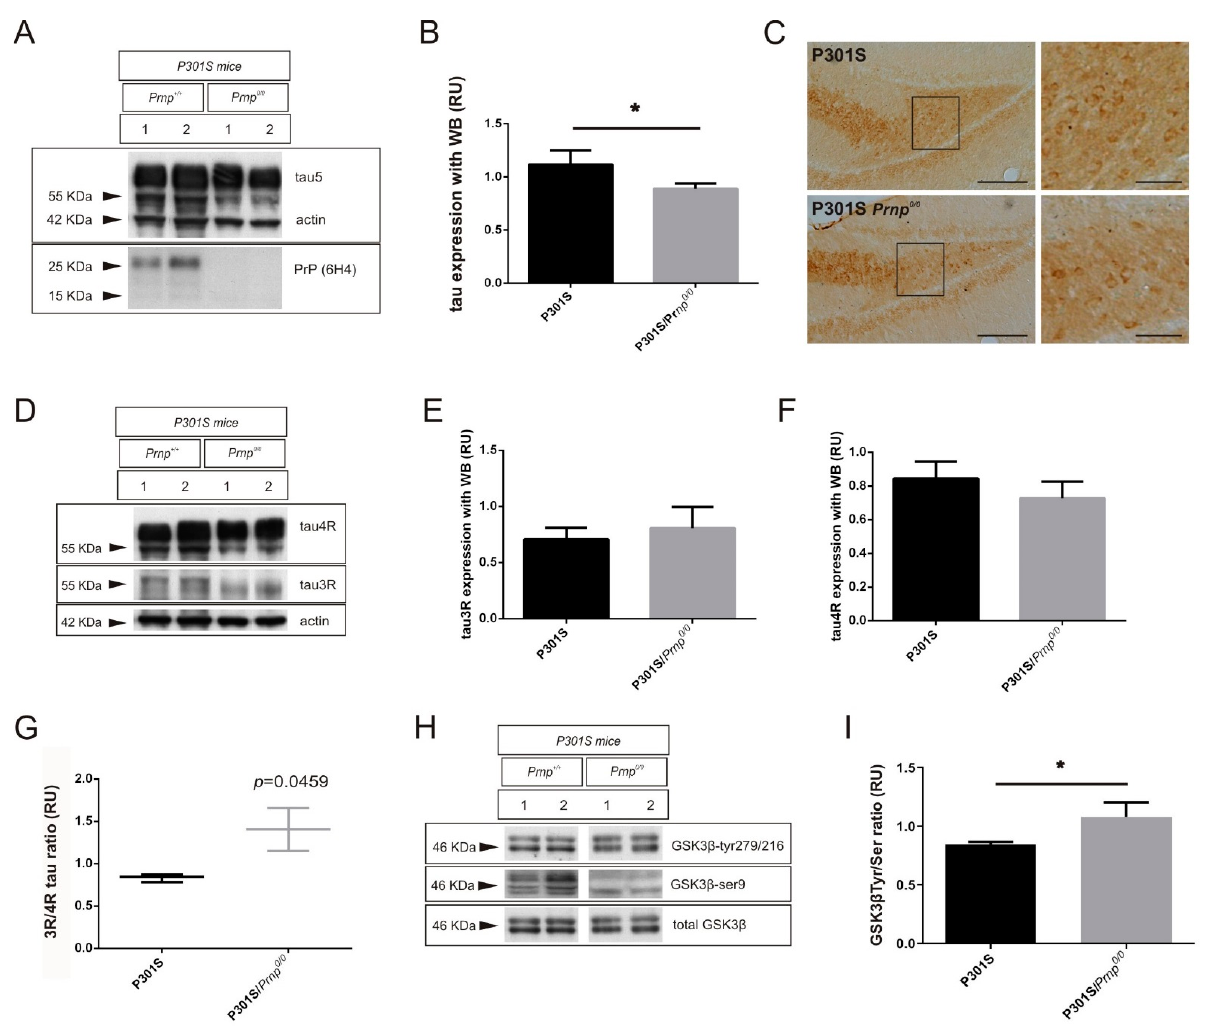
Figure 4. Effects on tau, alternative exon 10 forms, and GSK3 β in tau transgenic mice overexpressing human P301S MAPT mutation after ablation of PrP C expression. ( A – C ) Total tau expression analyzed in brain extract from P301S and P301S- Prnp 0/0 mice at the age of 3 months. ( A ) Representative WB analysis using total anti-tau antibody (monoclonal Tau5) in parallel with anti-PrP C antibody (monoclonal 6H4) in each case. Actin detection was used as control loading protein. ( B ) Histograms showing the densitometry study of both endogenous and overexpressed tau expression in each genotype. ( C ) Immunohistochemical detection of total tau in mouse brain sections from P301S and P301S- Prnp 0/0 . Monoclonal tau5 antibody was used to detect increased immunoreaction in DG from P301S in contrast to P301S- Prnp 0/0 animals. Scale bars = 100 µm and 50 µm. ( D – G ) Endogenous 3R and 4R tau isoform expression analyzed in brain extract from P301S and P301S- Prnp 0/0 mice at the age of 3 months. ( D ) Representative WB analysis using anti-3R tau antibody (monoclonal RD3) in parallel with anti-4R tau antibody (monoclonal RD4) in each genotype. Actin detection was used as control loading protein. ( E , F ) Histograms showing the densitometry study of 3R tau ( E ) and 4R tau ( F ) expression in each genotype. ( G ) Graphical representation of the 3R/4R tau ratio analyzed with data represented in ( E , F ). ( H , I ) GSK3 β activation analyzed with WB in brain extract from P301S and P301S- Prnp 0/0 mice at the age of 3 months. ( H ) Representative WB analysis using anti- phospho-tyr 279/216 GSK3 antibody (monoclonal 5G-2F) in parallel with anti-phospho-ser 9 GSK3 antibody (monoclonal 2D3) in each case. Membranes were re-probed with antibody against total GSK3 (monoclonal 4G-1E) for protein standardization. ( I ) Histograms showing the quantified ratio between phospho-tyr 279/216 and phospho-ser 9 after densitometry analysis of both phosphorylated GSK3 β epitopes in each genotype, which represents the kinase activity. n = 3 mice were examined in each group and data represents the mean ± S.E.M. Differences between groups were considered statistically significant at * p < 0.05 ( t -test).